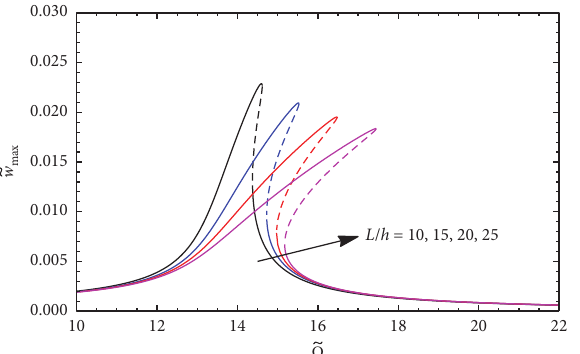
Figure 11: The effect of aspect ratio L / h on the frequency-response curves of transverse motion of SS BDFG porous beam with m � 0 . 1, 􏽥 c � 􏽥 c � 0 . 05, and 􏽥 f � 0 . α d r 0